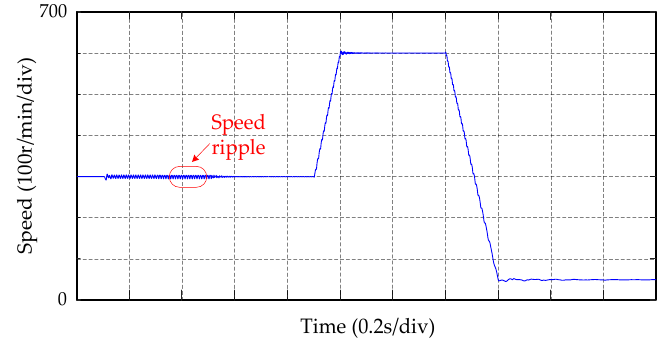
Figure 18. Speed waveform of five-phase PMSM at different speeds.